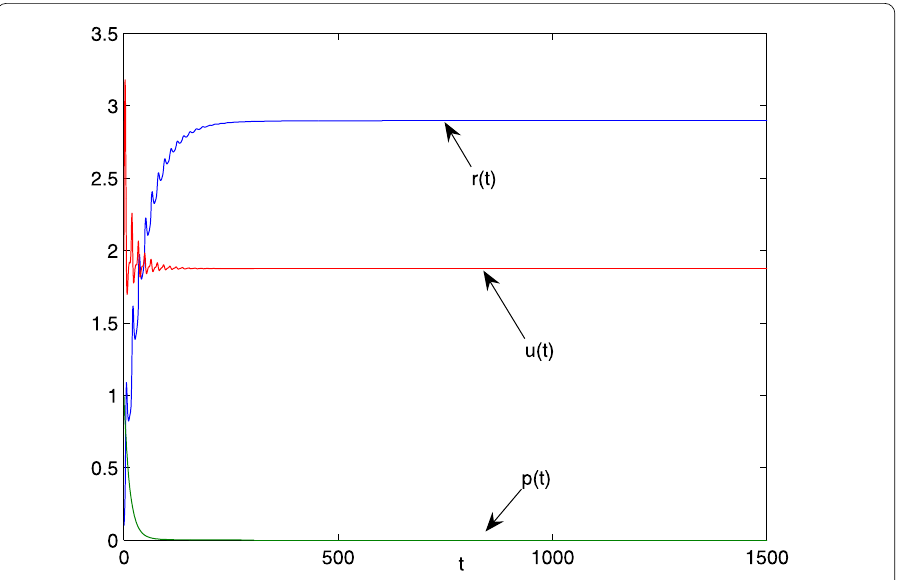
Figure 1 The asymptotical stability of ( r ∗ 2 , p ∗ 2 , u ∗ 2 ) = (2.8968,0,1.875). The parameters of system (5) are c 1 = 0.8, c 2 = 0.1, c 3 = 0.9, c 4 = 0.6, s 1 = 0.6, s 2 = 0.1, b = 1.1, d 1 = 0.9, d 2 = 0.1, d 3 = 0.1, α = 0.98, and τ = 13.5; the initial values are r ( t ) = 0.1, p ( t ) = 1, u ( t ) = 2 ( t ∈ [– τ